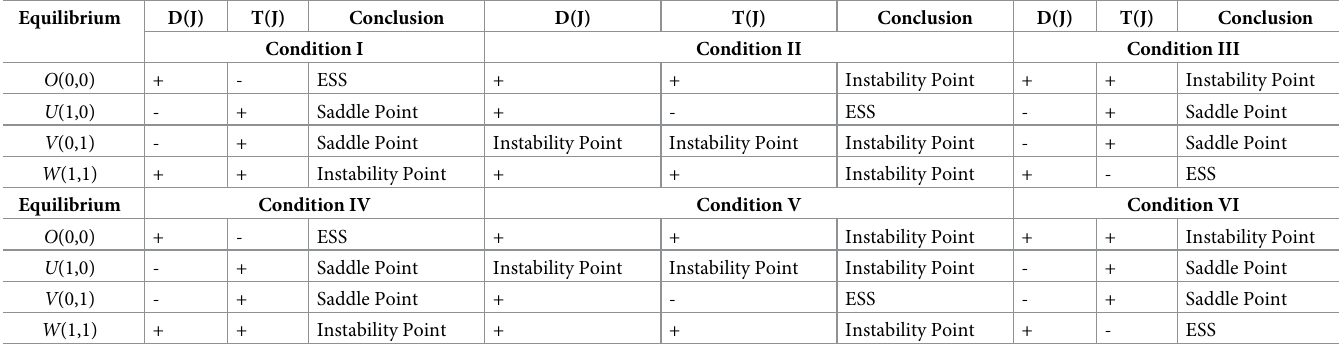
Table 3. Local stability analysis of the system.